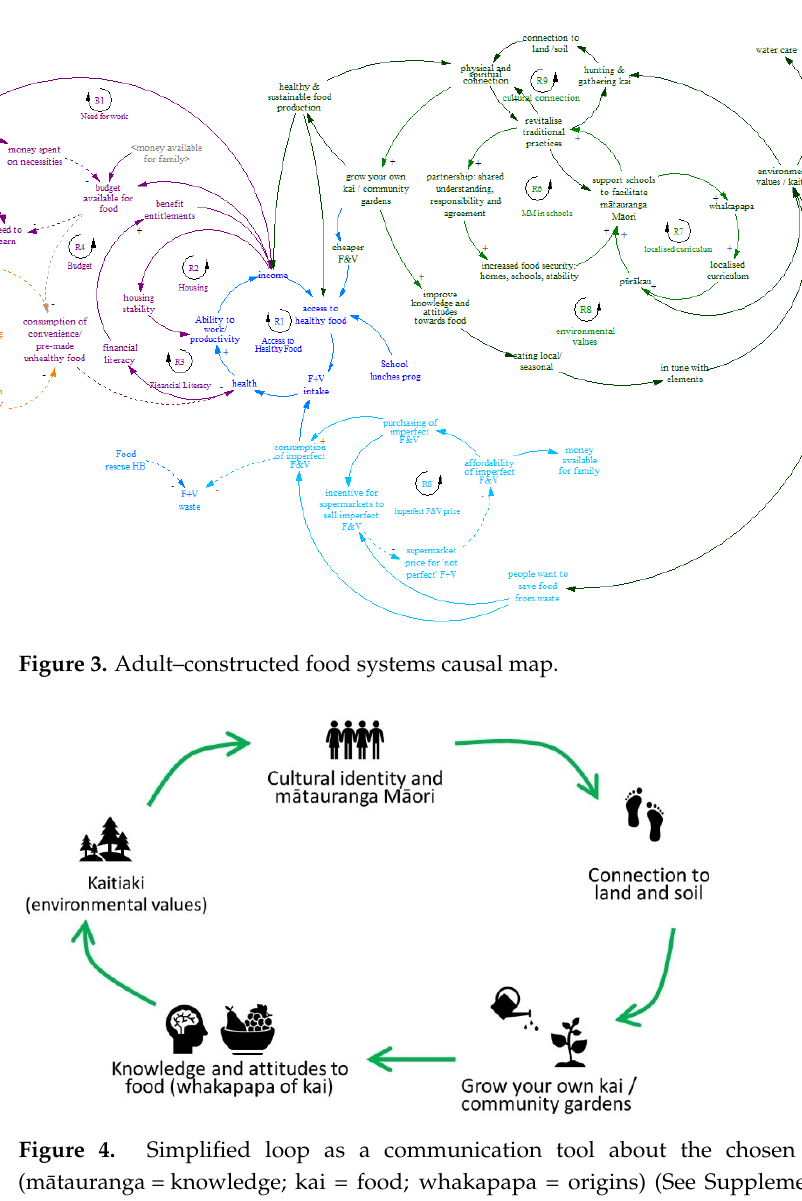
Figure 4. Simplified loop as a communication tool about the chosen intervention point (m ā tauranga = knowledge; kai = food; whakapapa = origins) (See Supplementary Materials for the hand-drawn loop drafted by a participant during the workshops).